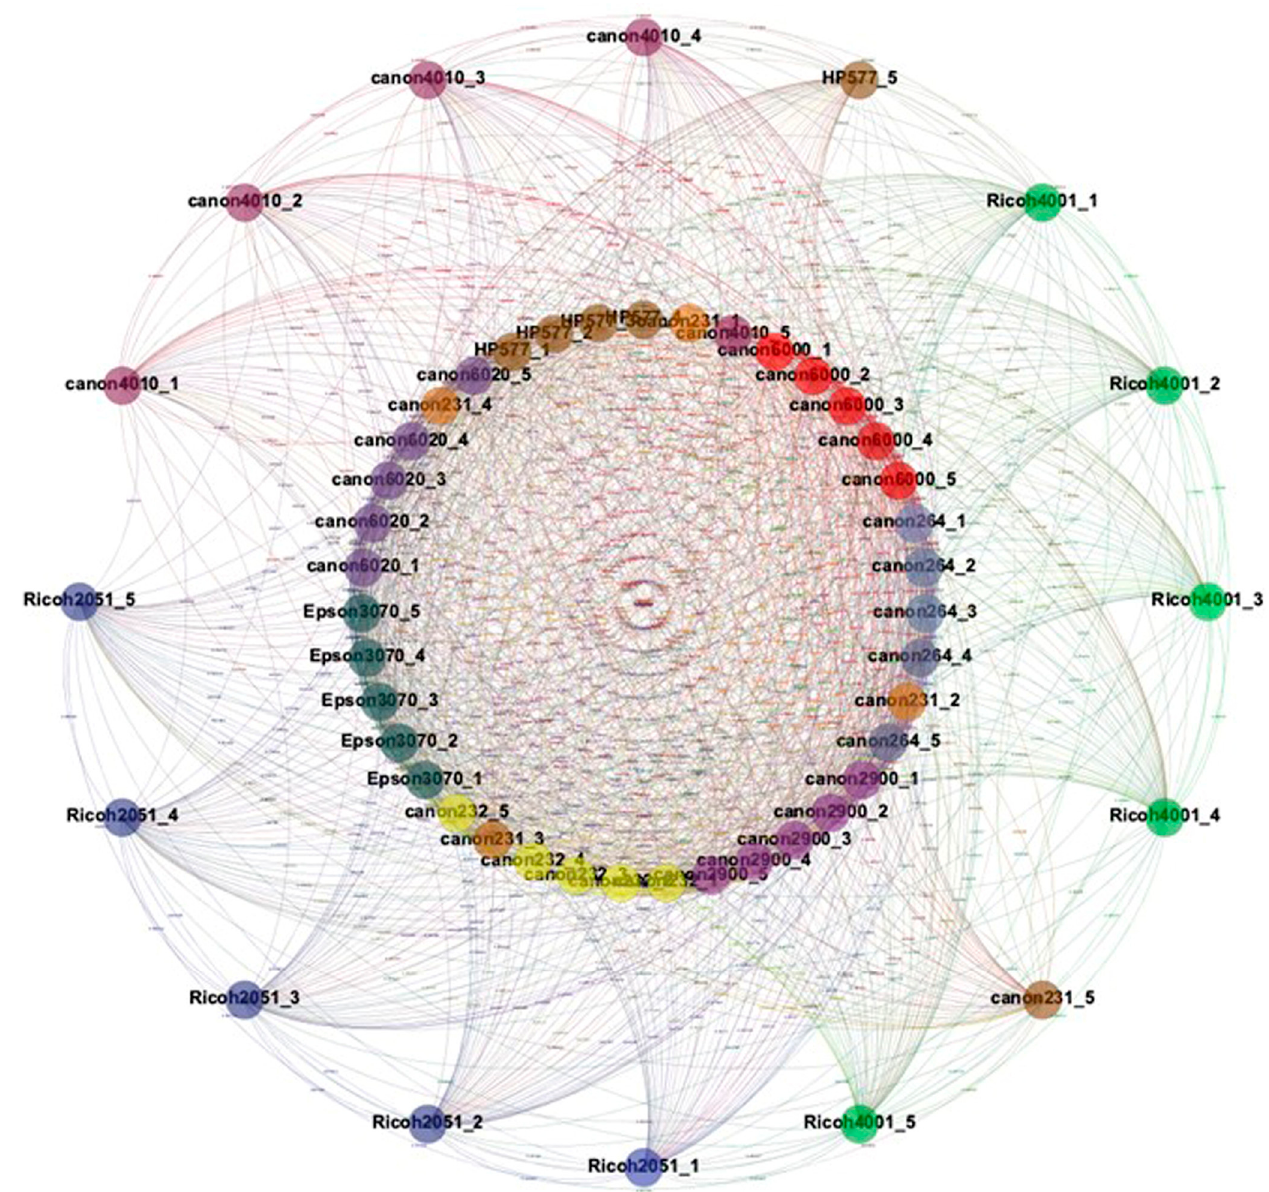
Figure 9. Test 5, testing many printers using the Louvain algorithm.